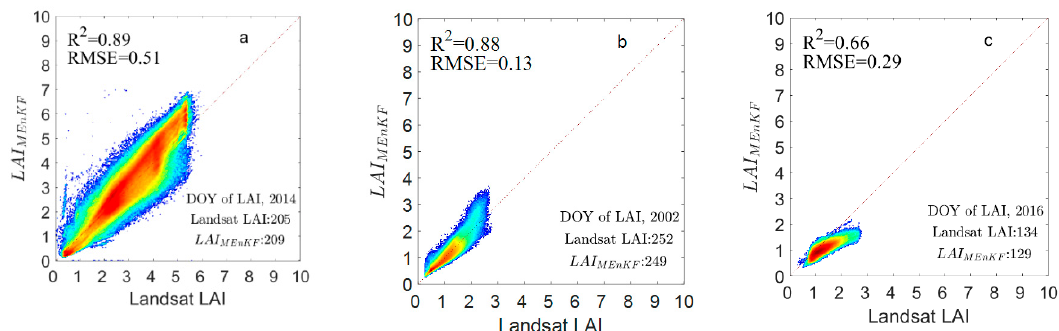
Figure 9. Scatterplot map of MEnKF LAI with Landsat LAI. ( a ) Farmland, ( b ) grassland, and ( c ) woodland.